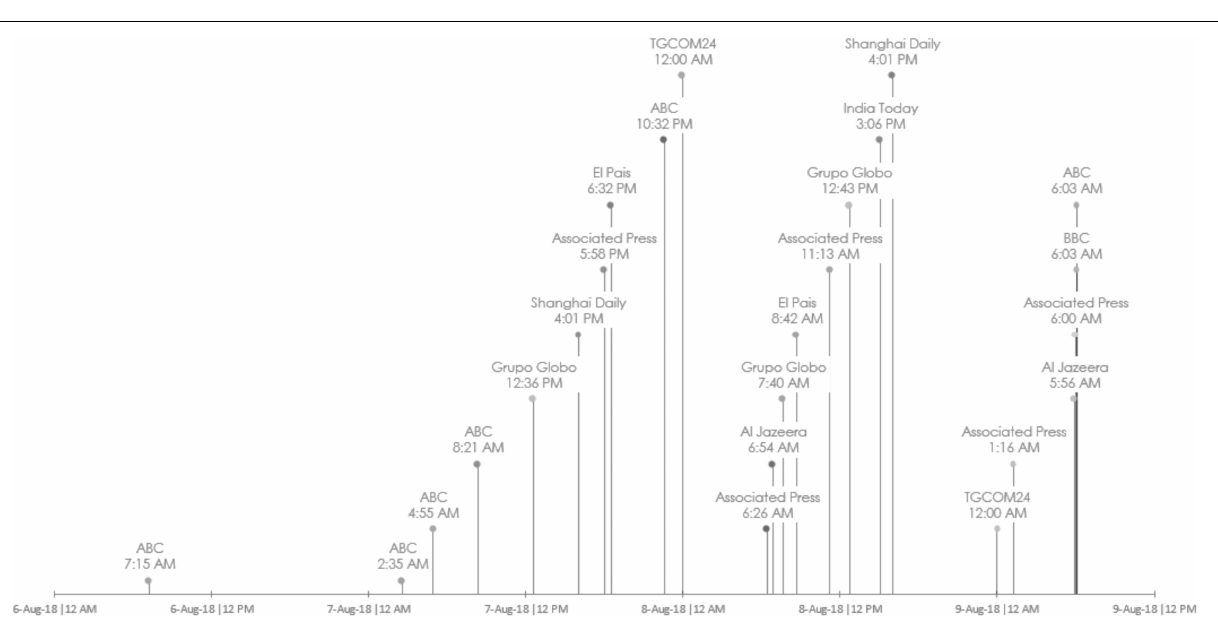
FIGURE 5 | Timeline showing the reports from different news agencies as Indonesia was experiencing earthquakes frequently. The date represents the timestamp when the article was published by the news